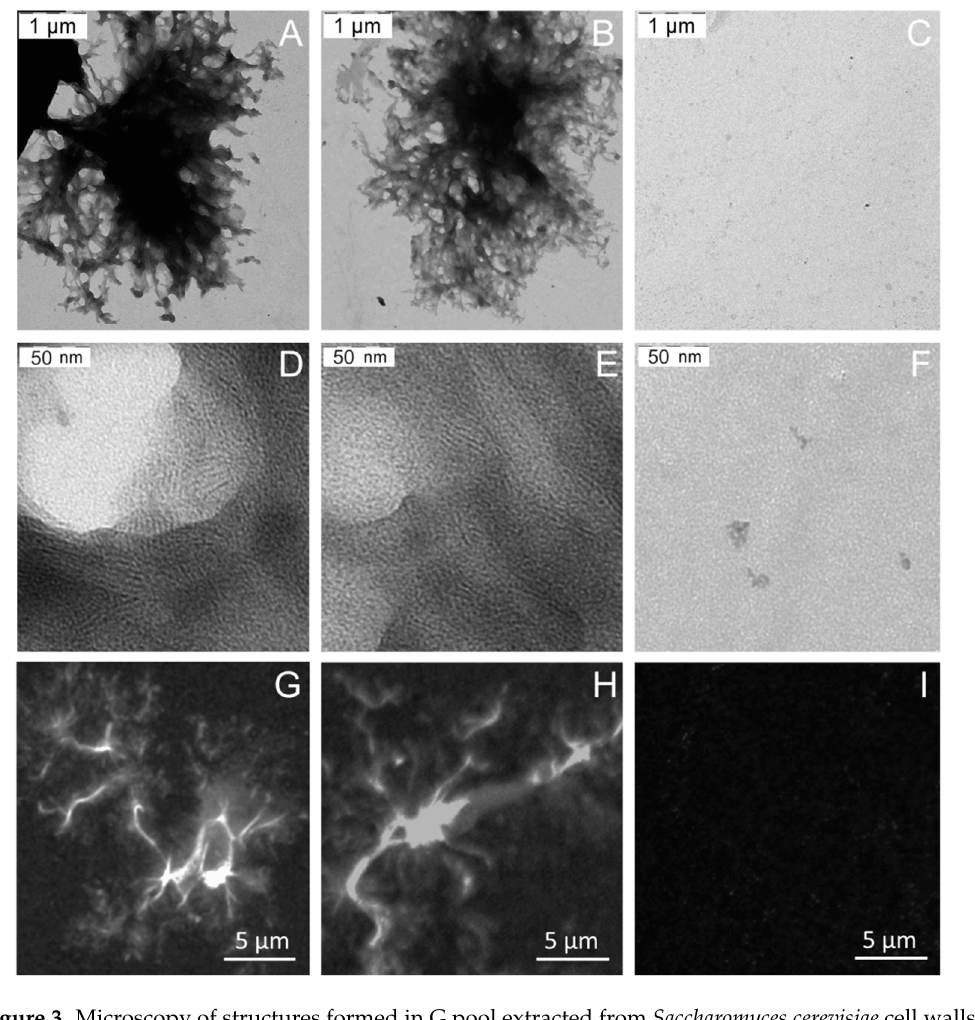
Figure 3. Microscopy of structures formed in G pool extracted from Saccharomyces cerevisiae cell walls: TEM ( A – F ), immunofluorescence microscopy, staining with antibodies against Bgl2 ( G – I ). General view of jellyfish-like associates obtained from wt strain ( A , B , G , H ), fibrillar structure of their bodies ( D , E ). Control samples from bgl2 Δ strain ( C , F , I ).